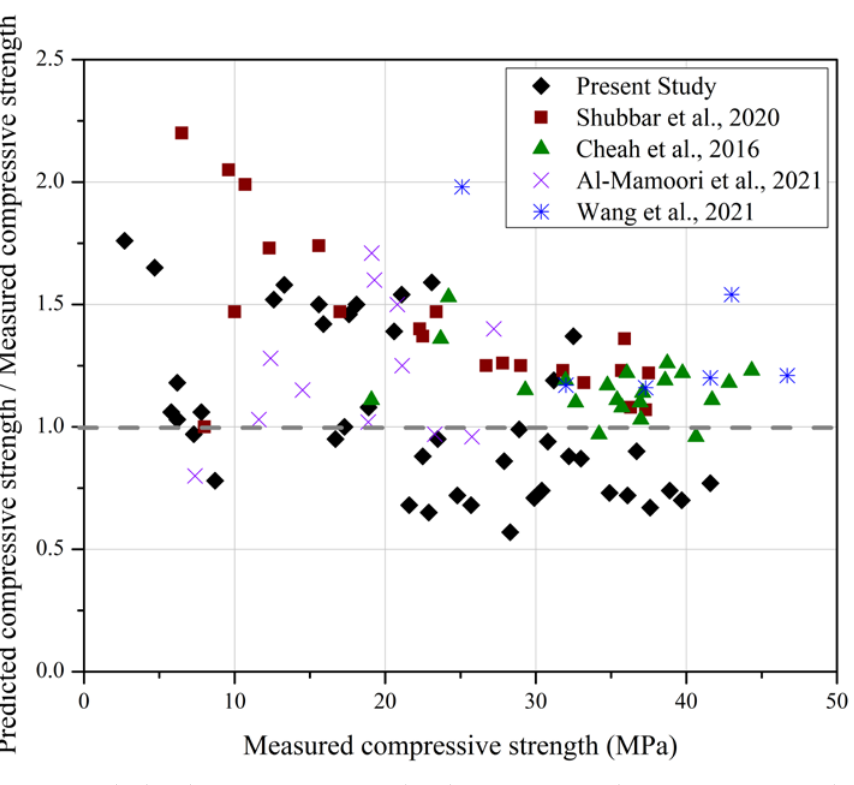
Figure 7. Calculated compressive strength values-to-measured compressive strength values ratio using Equation (2) [38–41].